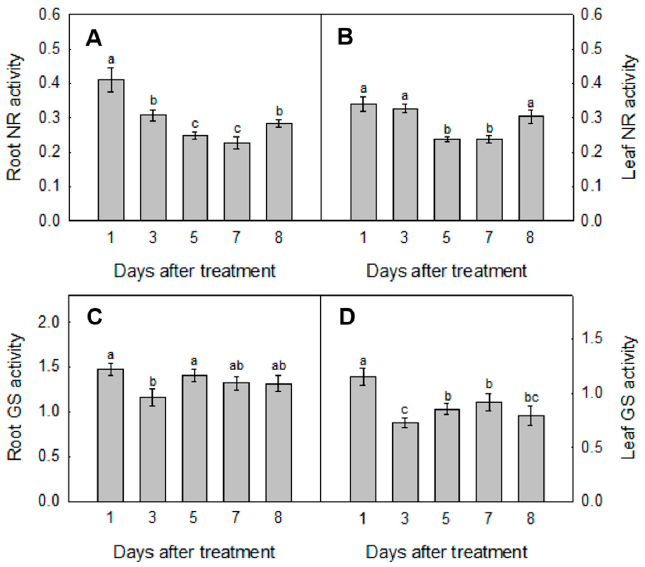
Figure 3. The e ff ect of drought and rewatering on activities of nitrate reductase (NR; nmol NO 3 − h − 1 mg − 1 protein) and glutamine synthetase (GS; h − 1 mg − 1 protein) in roots ( A , C ) and leaves ( B , D ) of Malus hupehensis plants. Bars labelled with di ff erent le tt ers indicate signi fi cant di ff erence.